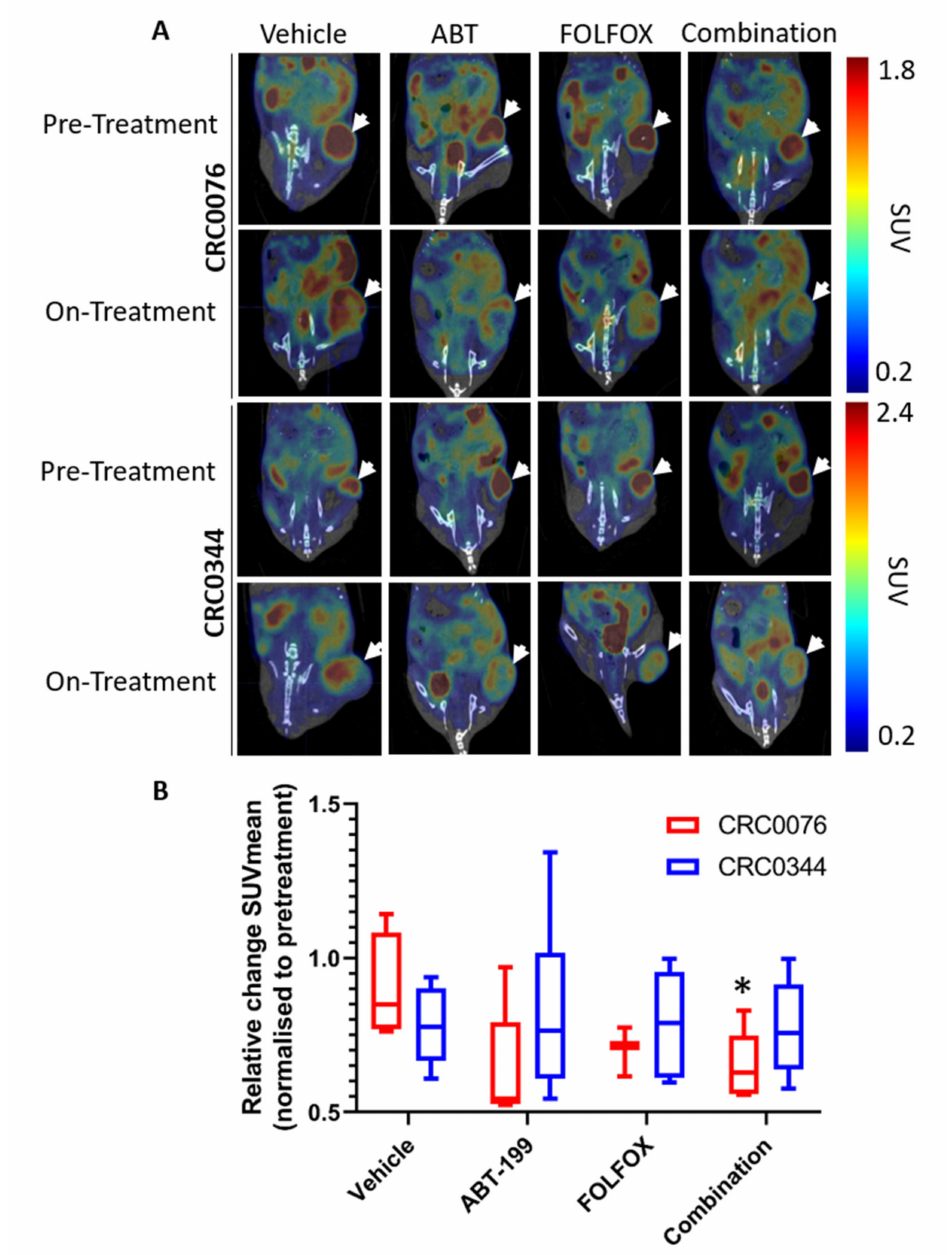
Figure 4. Analysis of glucose uptake and metabolism in the predicted combination responder CRC0076 and the predicted FOLFOX alone responder CRC0344 PDX models. For imaging, n = 6 mice / group / PDX (at pre-treatment time point) received 18 F-FDG via tail vein injection, with image acquisition taking place 1 h after injection. Representative fused PET / CT images of CRC0076 and CRC0344 PDXs are shown (the same mice at pre- and on-treatment time points). White arrows indicate the tumours, scale bar indicates standard uptake values (SUVs) ( A ). N.B. Animals were imaged in a prone position. The coronal plane shown is positioned at the centre of the tumour which is located posterior to the bladder. Where the coronal plane intersects with the bladder, urinary excretion of FDG is observed as an intense signal. Comparison of relative change SUVmean at week 2 of treatment normalised to pre-treatment for CRC0076 and CRC0344 PDXs is presented. Error bars = s.e.m., * p ≤ 0.05 (paired t -tests, adjusted Holms) ( B